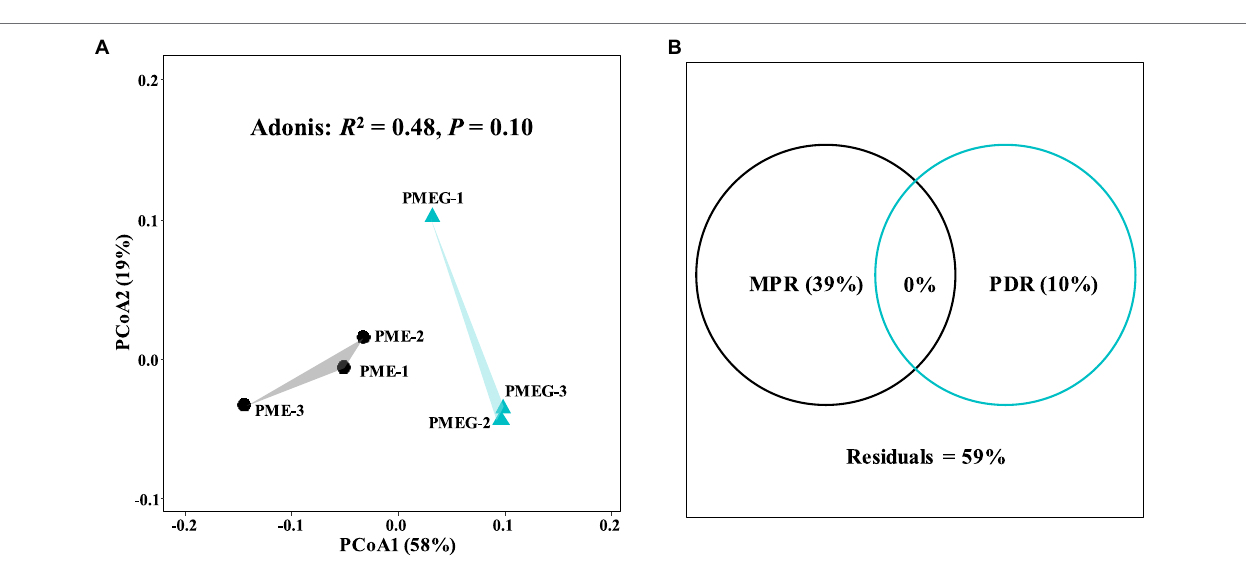
FIGURE 6 | The PCoA profile based on the functional enzymes composition in the PME and PMEG treatments (A) and variance partitioning analysis showing the portions explained by MPR and PDR for functional enzymes composition (B)